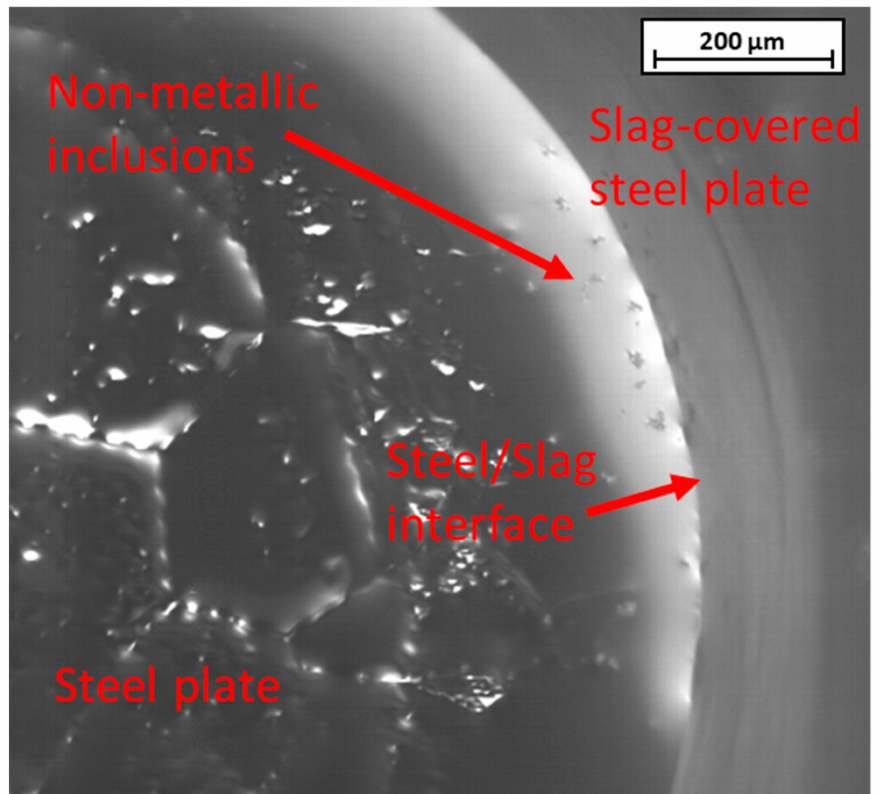
Figure 6. Partly molten steel covered with slag on the right and visible